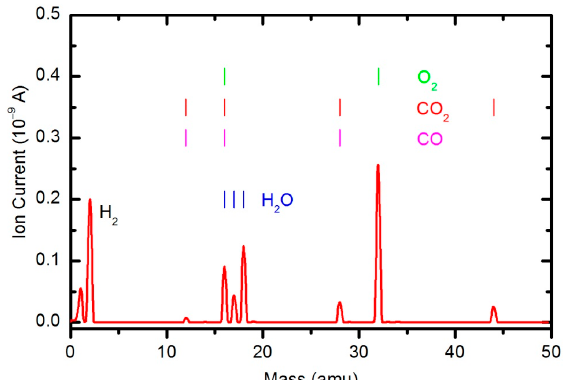
Figure 11. A mass spectrum measured in a chamber loaded with PURPEG samples after plasma treatment for 30 s. The pressure was 33 Pa and forward power 150 W.